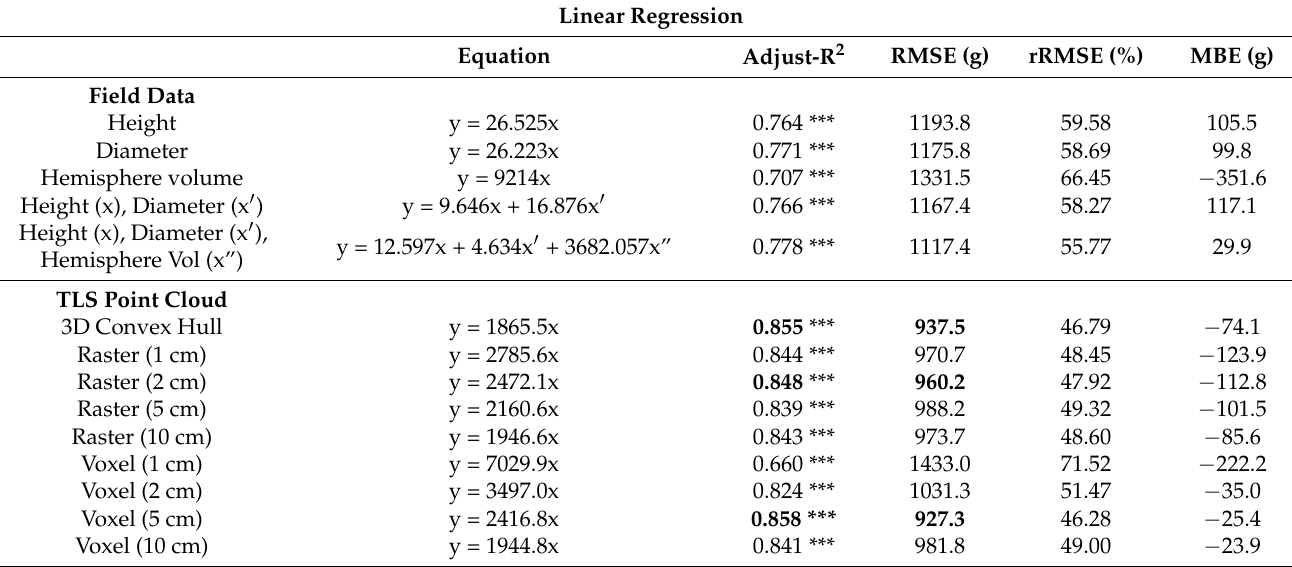
Table 3. Linear regression equations derived by OLS between AGB (y, g) and field measurements, plant volume (m 3 ) obtained by the hemisphere volume, and plant volume obtained by TLS methods (3D convex hull, voxel, and raster-based models). Values in bold reflect the best fit for each approach. *** indicates a significant relationship at p -values <